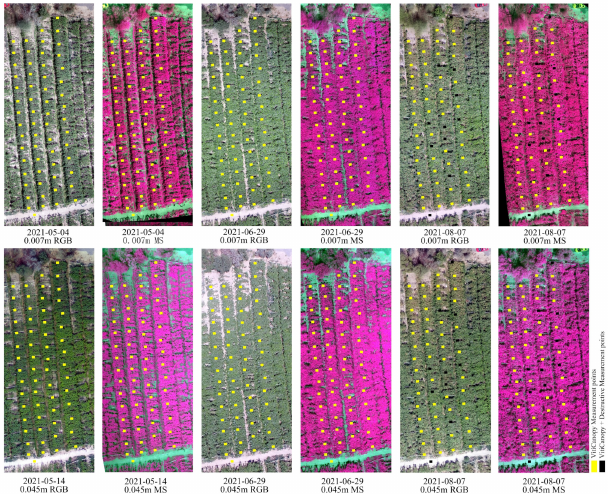
Figure 3. Locations of VitiCanopy and destructive sampling measurements. Ortho mosaiced RGB and false color images of sampled vineyard with 0.007 m and 0.045 m GSD on different dates. The yellow and black rectangles refer to 0.80 m × 0.90 m regions which were measured using VitiCanopy and black rectangles refer to the plots of the destructive sampling